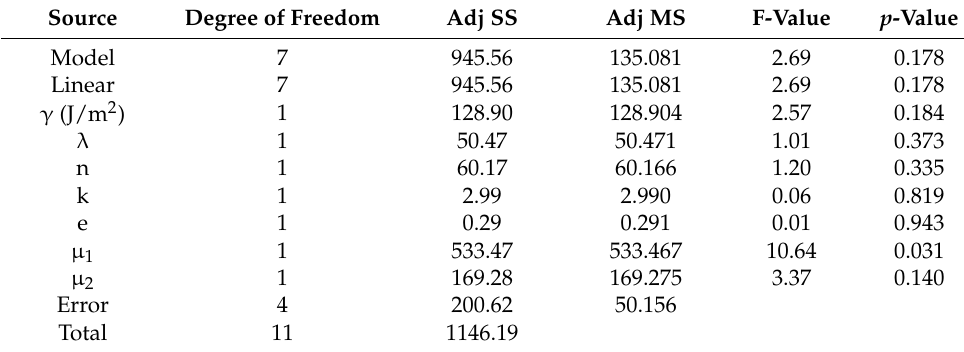
Table 3. Analysis of variance of PBD